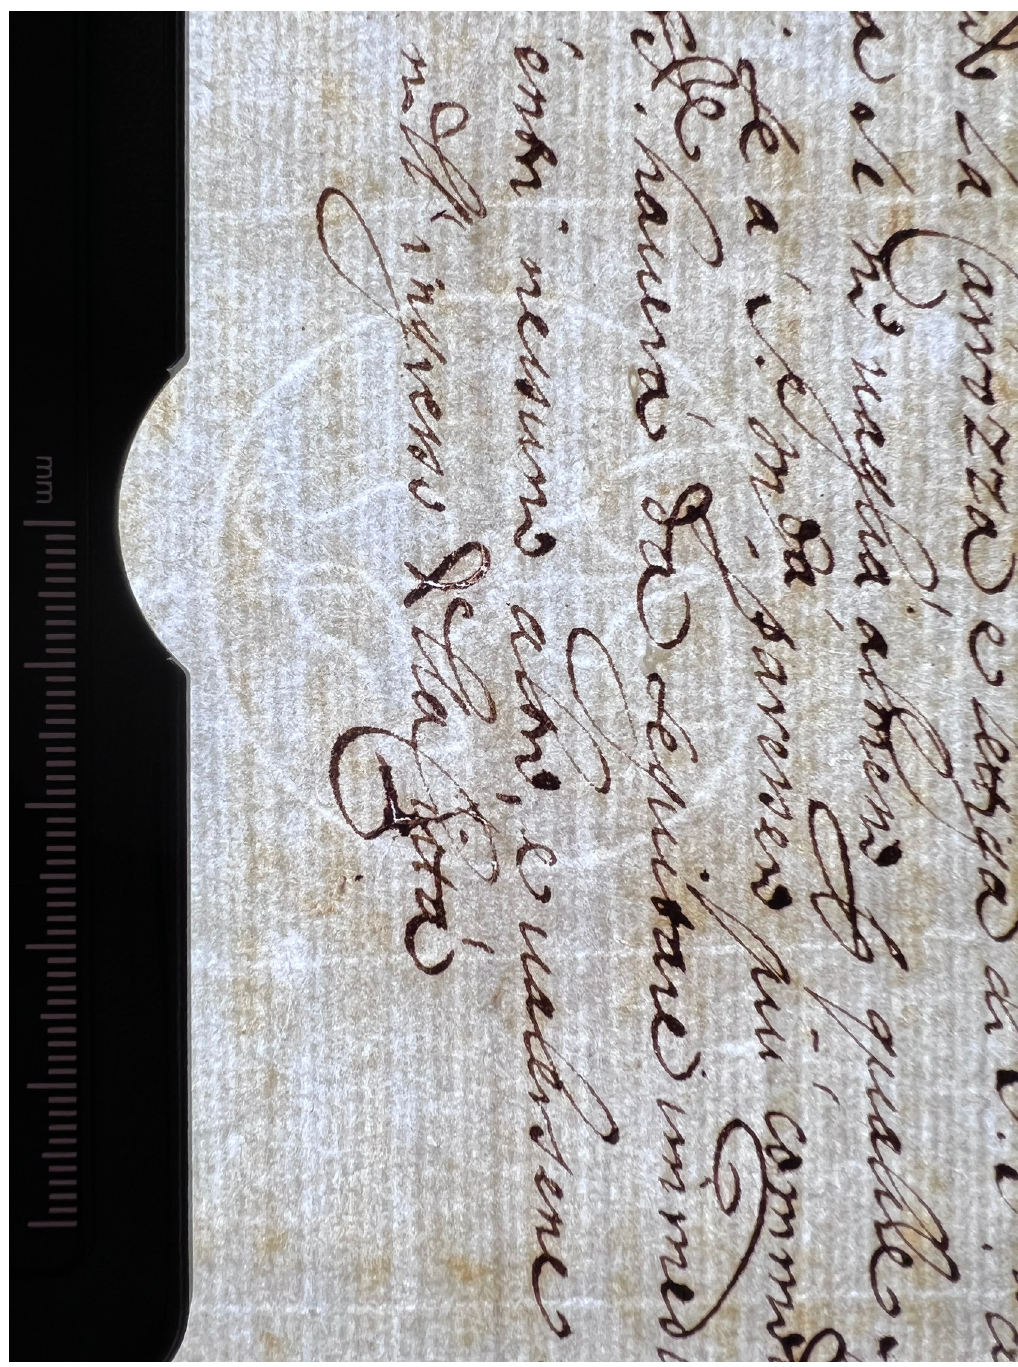
Fig 7. Cracks and watermarks. Cracks in ink and watermark in paper visualized through transmitted light. This particular document from volume K 400 of the Azzolino